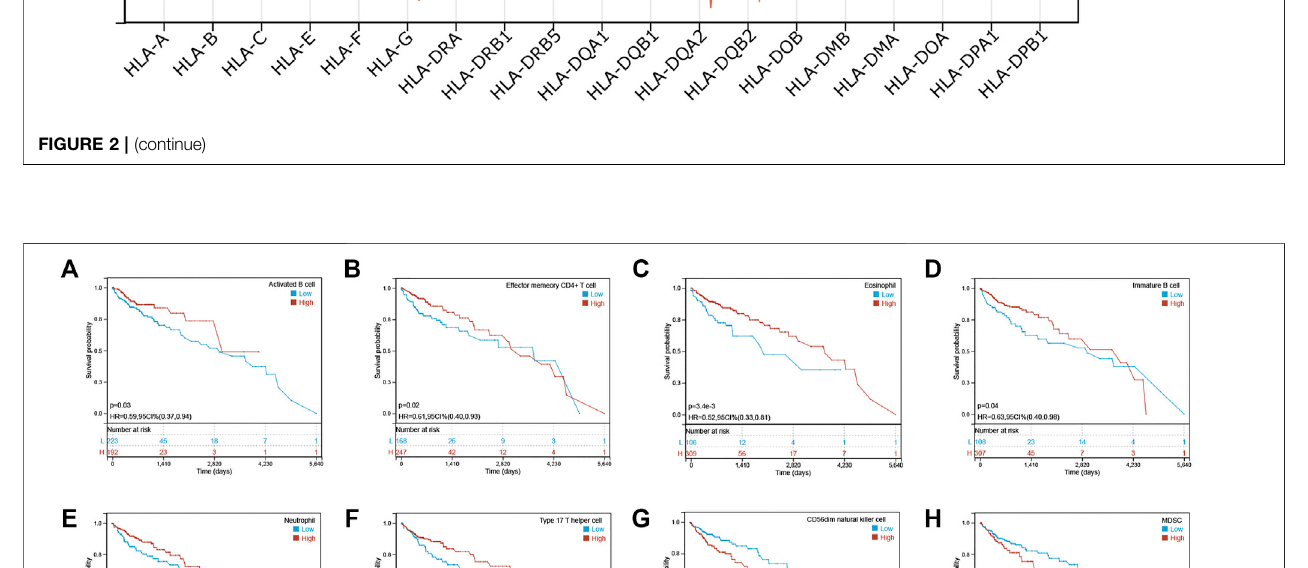
Frontiers in Bioengineering and Biotechnology |